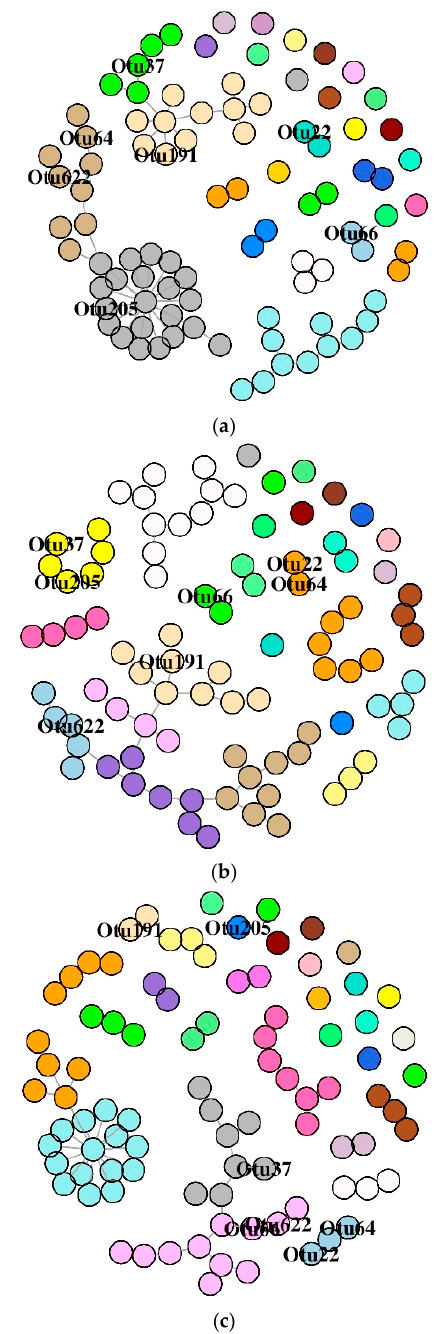
Figure 7. Association network graphs of the significantly abundant OTUs of Atlantic salmon. Distal intestine mucus bacterial networks of the control ( a ), florfenicol-fed ( b ), and oxolinic-acid-fed ( c ) fish. Nodes represent OTUs and specific colors of the modules reveal the memberships of the significantly abundant OTUs.